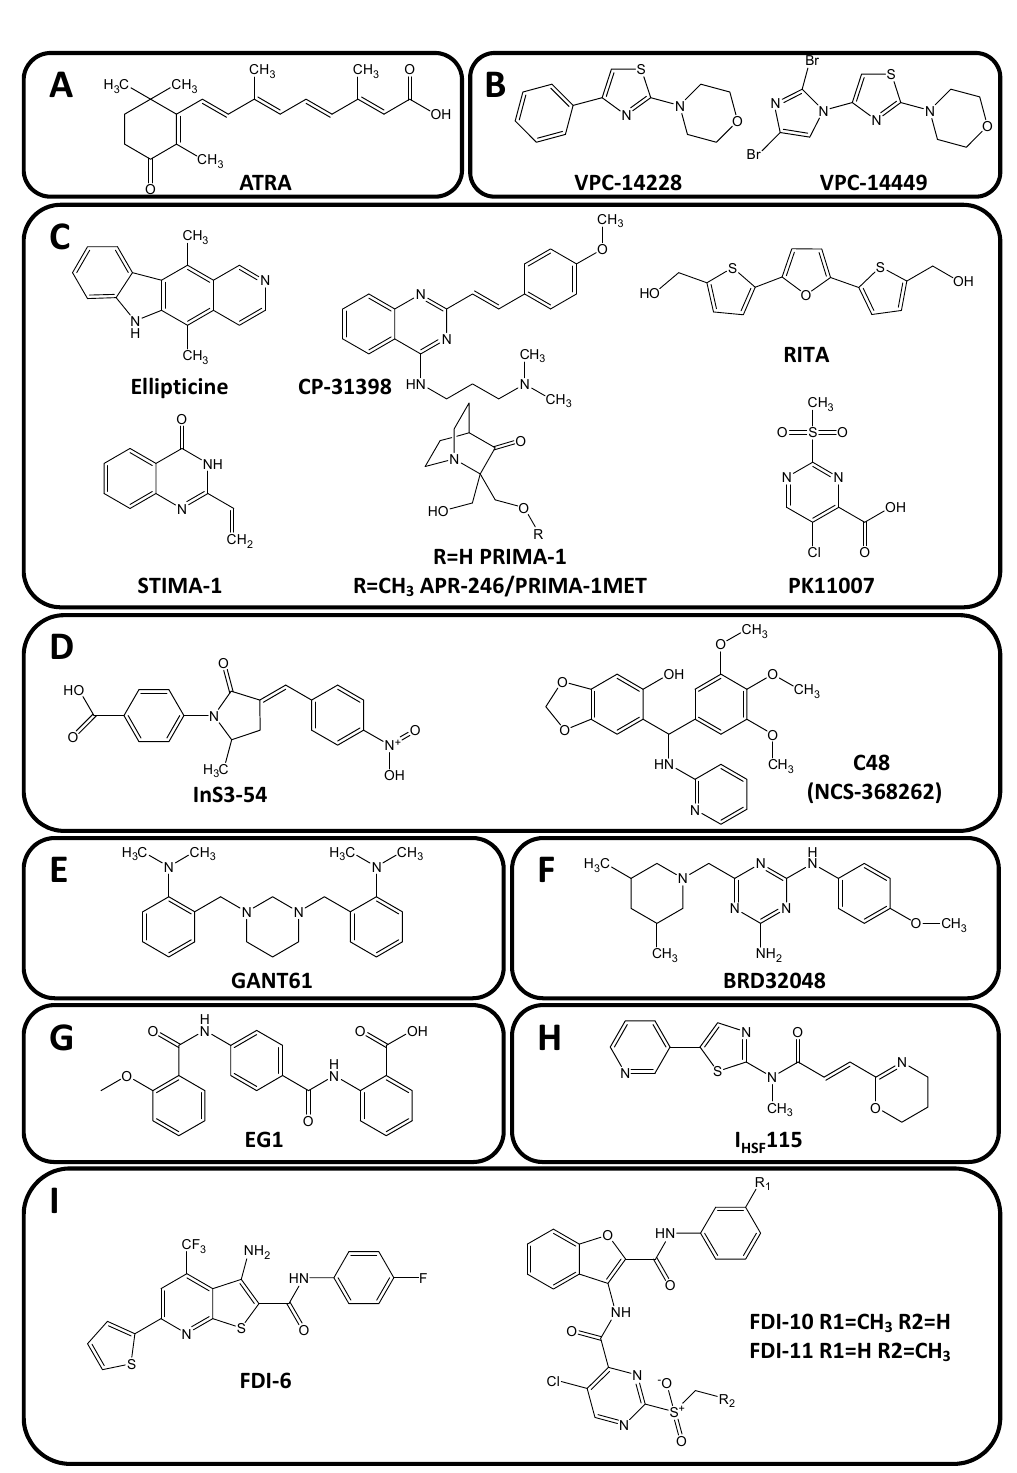
Figure 5. Direct targeting of transcription factors. ( A ) PML-RAR α ; ( B ) Androgen receptor; ( C ) p53. ( D ) STAT3; ( E ) GLI1/2; ( F ) ETV1; ( G ) PAX2; ( H ) HSF1; ( I ) FOXM1. Other compounds were developed to target transcription factors, but it is not yet clear whether they directly inhibit the transcription factor or whether they affect some unclear or yet unknown BRD32048 (Figure 5F) is another tri-cyclic compound that targets the DNA binding domain of a transcription factor. Indeed BRD32048 directly binds ETV1, a member of the ETS transcription factor family translocated in prostate cancer and Ewing sarcoma, and inhibits its transcriptional activity on MMP1 promoter. In agreement with MMP1 reduced expression, BRD32048 inhibition of